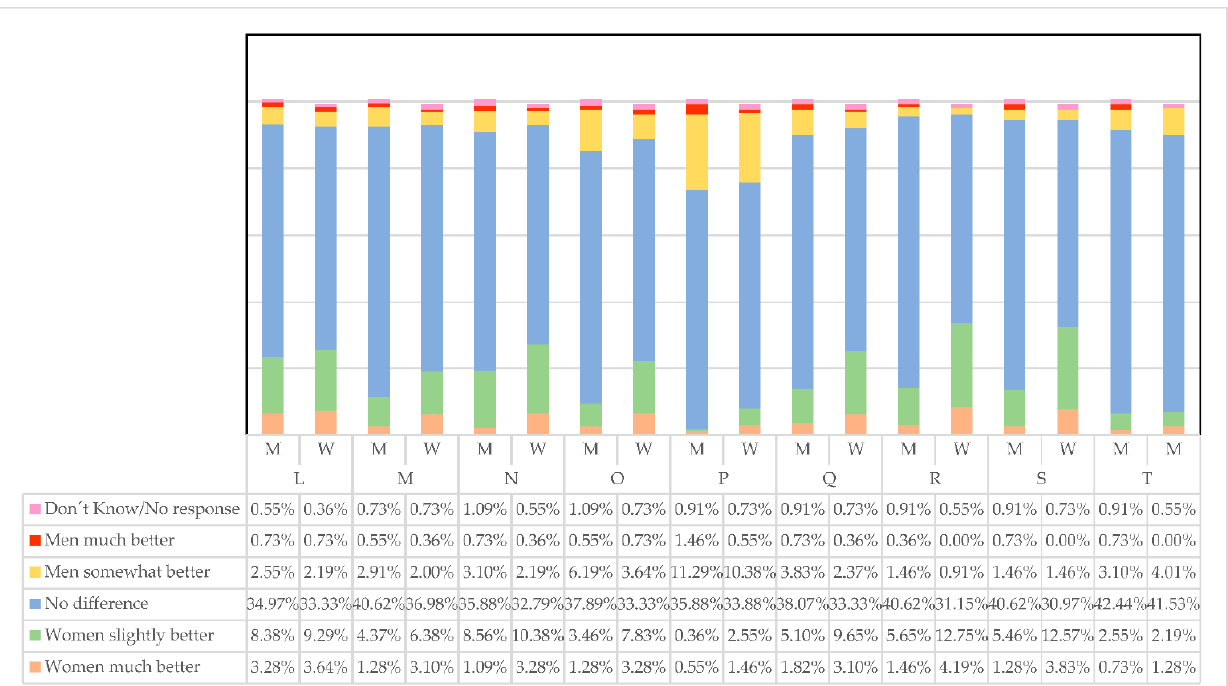
Figure 1. Qualities required to be an efficient leader. Source: Own elaboration.